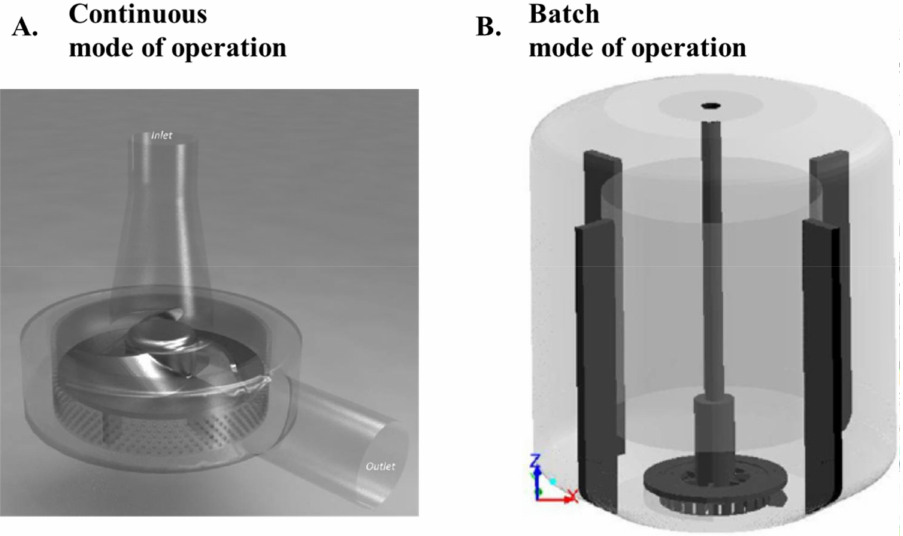
Figure 2. Schematics of RSMs for use in continuous ( A ) and batch ( B ) mode of